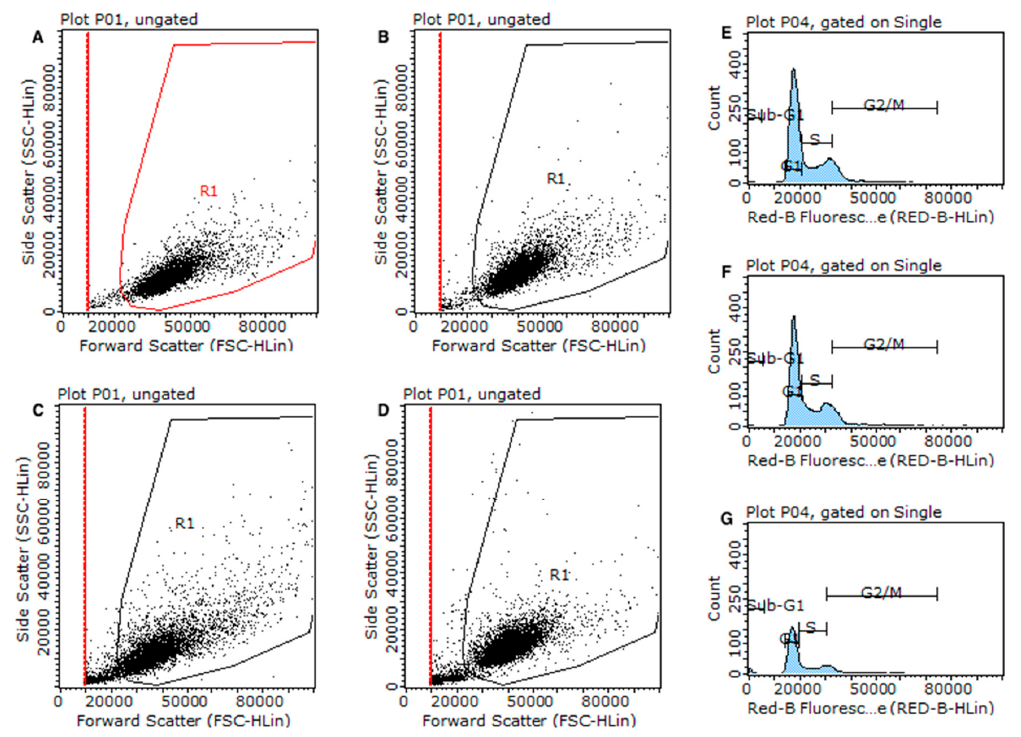
Figure 12. Representative images of viable cell gating (side scatter (SSC) vs. forward scatter (FSC) ( A – D ) and histograms of cell cycle analyzed by flow cytometry (Sub- G 1, G 0 / G 1, S, and G 2 / M ) in A549 cells after exposure to CeO 2 NP 10 µ g / L ( E ), Hg 20 mg / L ( F ) and the mixture CeO 2 NP10 / Hg20 ( G ). The y -axis shows the number of cells counted and the x -axis shows an increasing amount of PI incorporation / cell (right). Experiments performed in triplicate yielded similar results.